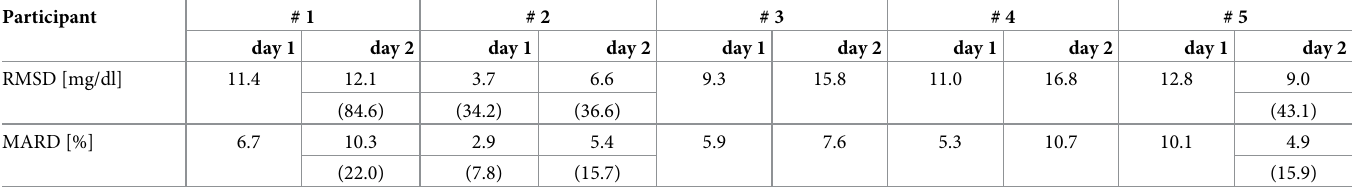
Table 1. Evaluation of personalized model fits. Unexplained glucose excursions are excluded and results for the full 24h period are given in brackets in these cases. Participant